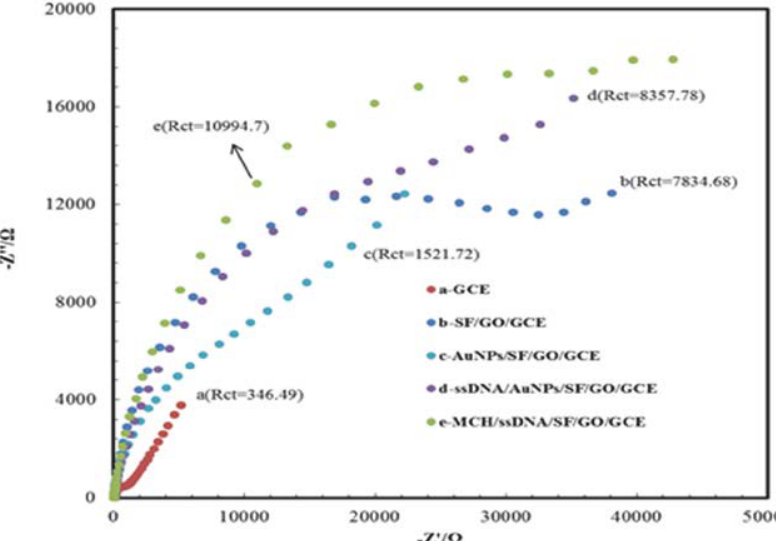
Figure 4. Electrochemical impedance spectroscopy (EIS) signals obtained for a 1.0 mmol L –1 [Fe(CN) 6 ] 3–/4– and 0.1 mol L –1 KCl solution at the surfaces of (a) bare GCE, (b) GO/SF/GCE, (c) AuNPs/GO/SF/GCE, (d) ssDNA/ AuNPs/GO/SF/GCE, (e) MCH/ssDNA/AuNPs/GO/SF/GCE (EIS conditions: initial ac potential 0.20 V with an AC amplitude of 5 mV and frequency range 10 kHz to 0.1